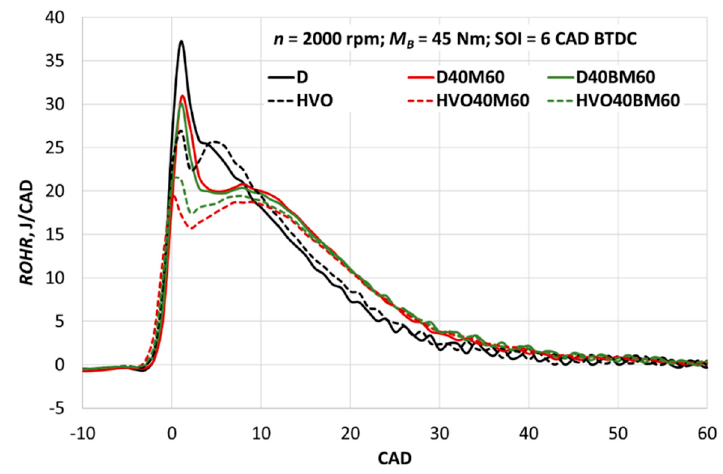
Figure 11. Rate of heat release in the cylinder depending on fuel composition.